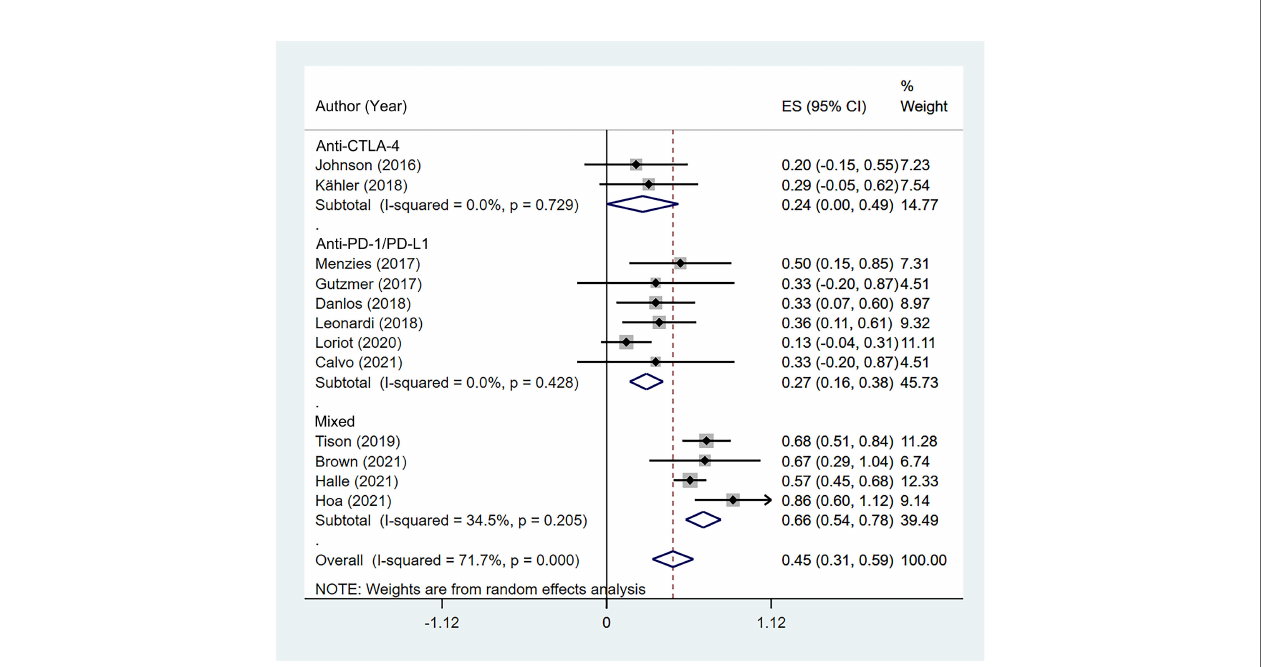
FIGURE 3 | Subgroup analysis of the pooled incidence of fl are in patients with cancer and preexisting psoriasis based on the class of immune checkpoint inhibitors (ICIs).